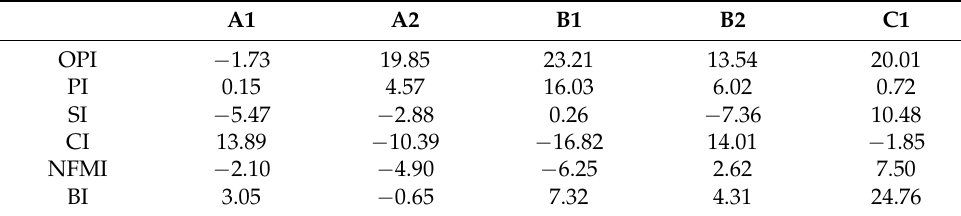
Table 5. Cumulative anomalies of net spillover between the carbon market and different sectors under different exogenous event shocks.